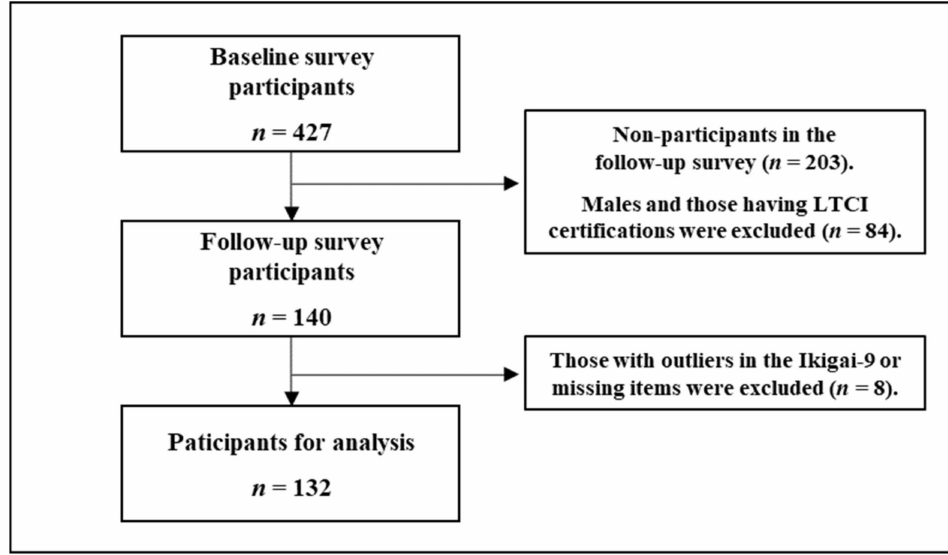
Figure 1. Flow chart presenting the selection procedure of the study